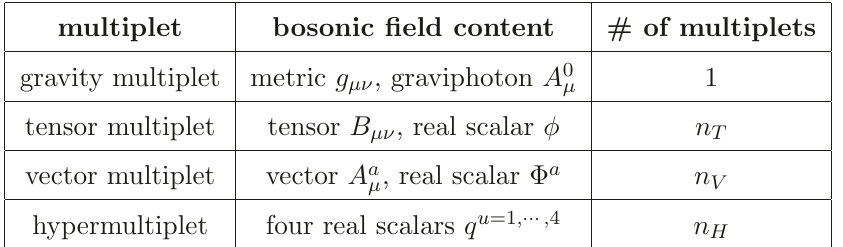
Table 1 . Multiplets of five-dimensional